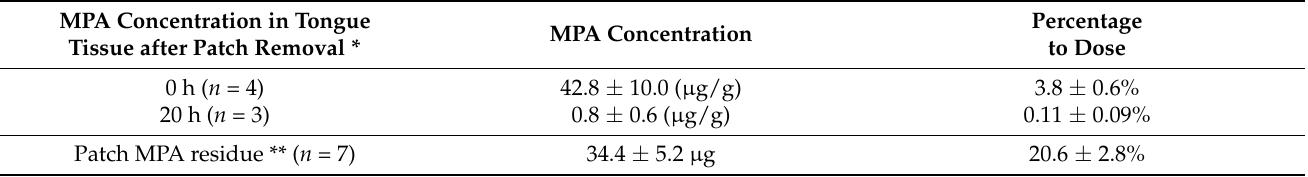
Table 2. MPA concentrations stored in tongue tissue and remaining in